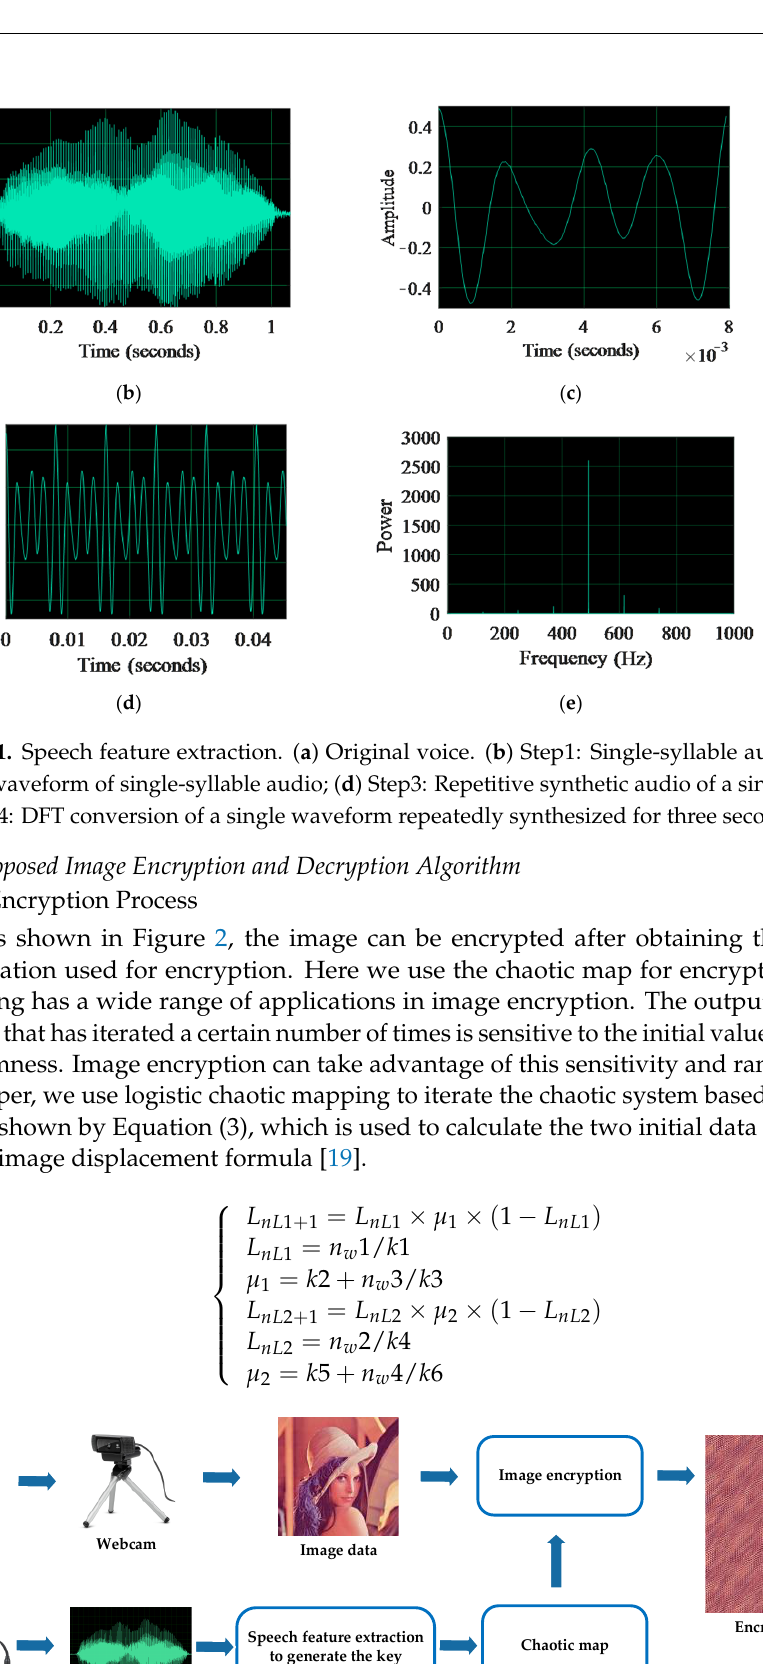
Figure 2. Encryption process.